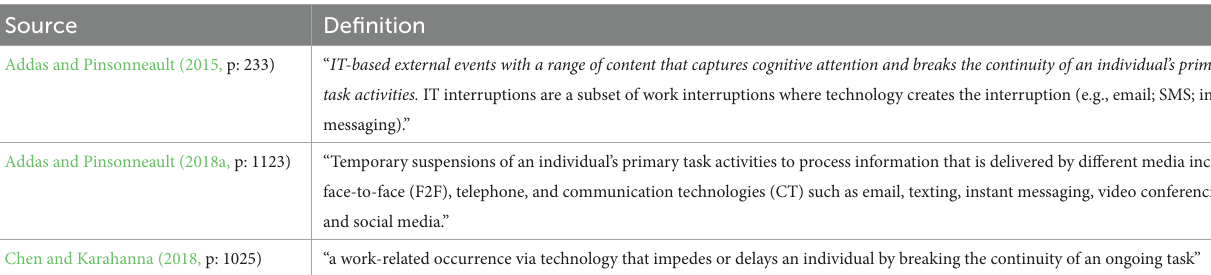
TABLE 3 Definitions of IT-mediated